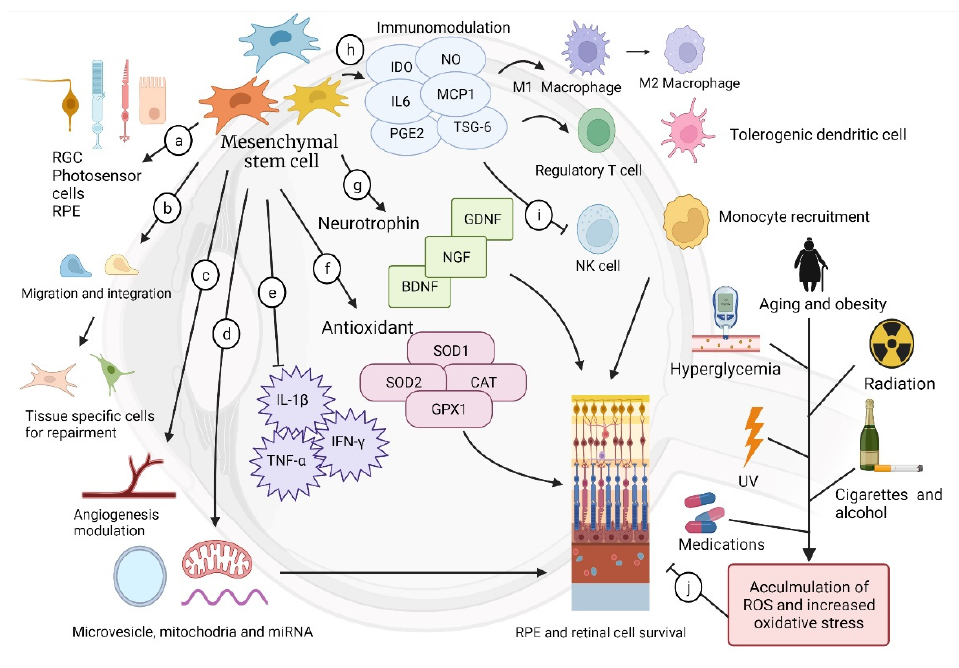
Figure 2. (a) MSCs can differentiate into retinal cells as MSC-derived organoids for replacement therapy. (b) After being delivered into eyes, MSCs are shown to be able to migrate and integrate into the inflammation site, then differentiate into tissue-specific cells to repair injured tissue. (c) MSCs exert angiogenesis or anti-angiogenesis, depending on the microenvironment. (d) Interaction between MSCs and other cells relied on release of microvesicles, mRNA, or mitochondria as cellular communication signals. (e) MSCs are known to reduce inflammation factors. (f) MSCs can upregu- late gene encoding for antioxidant enzymes to eliminate ROS. (g) Neurotrophins support neural